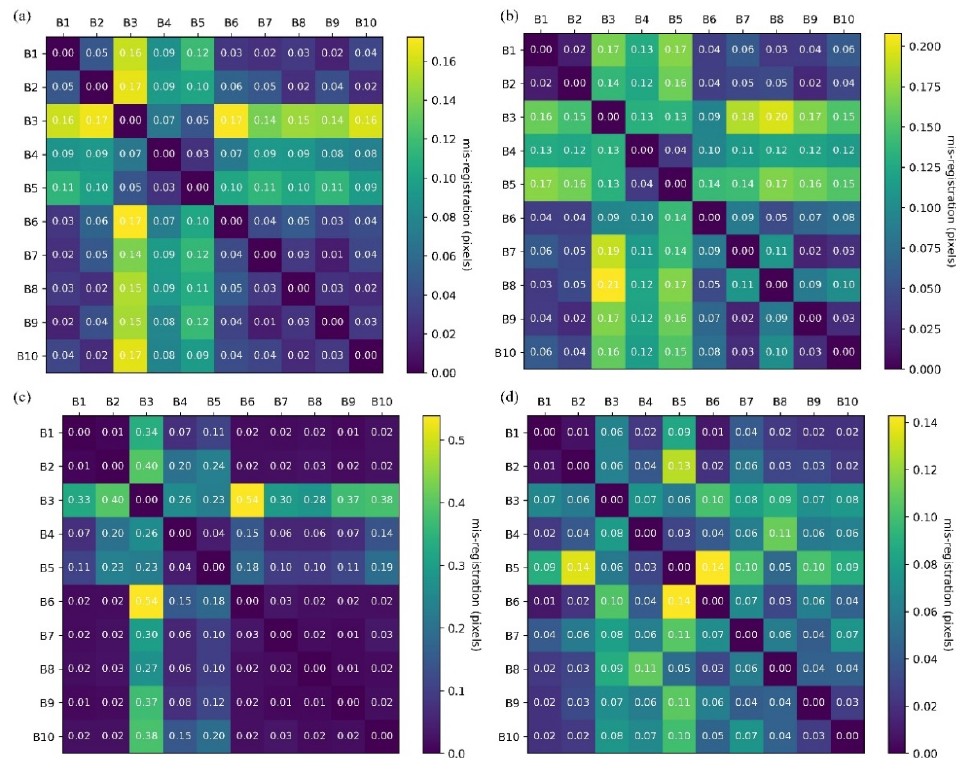
Figure 8. Band-to-band misregistration of FY1C/1D after co-registration. ( a ) the misregistration of FY-1D in the along-scan direction. ( b ) the misregistration of FY-1D in the along-track direction. ( c ) the misregistration of FY-1C in the along-scan direction. ( d ) the misregistration of FY-1C in the along-track direction.